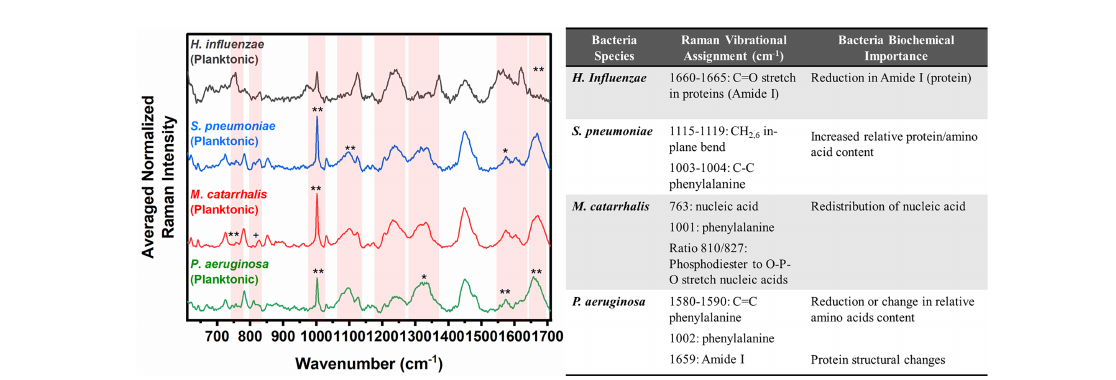
FIGURE 3 Averaged Raman spectra (left) highlighting key Raman features identi fi ed by SMLR to differentiate OM-causing bacteria planktonic form. The table (right) provides a summary of the tentative biochemical assignments of the Raman peaks. The red bands highlight the wavenumbers with SMLR weighted features contributing to *60-79% and ** ≥ 80% in differentiating amongst the species ’ planktonic cells ( +spectral changes observed visually but not identi fi ed by the SMLR model ).